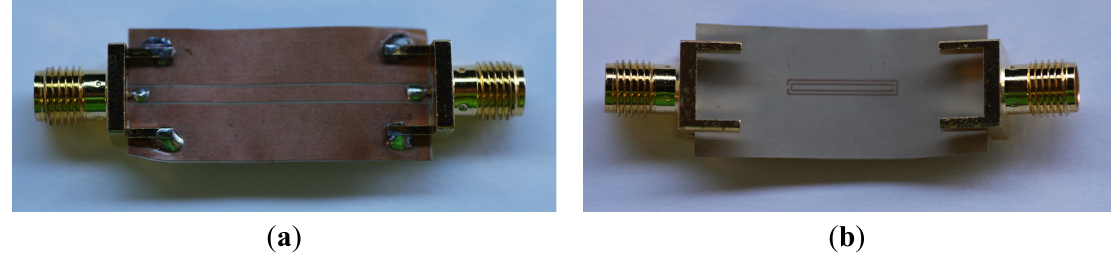
Figure 7. Photograph of the fabricated base structure; ( a ) top view of the CPW; and ( b ) SRR etched in the back substrate side.